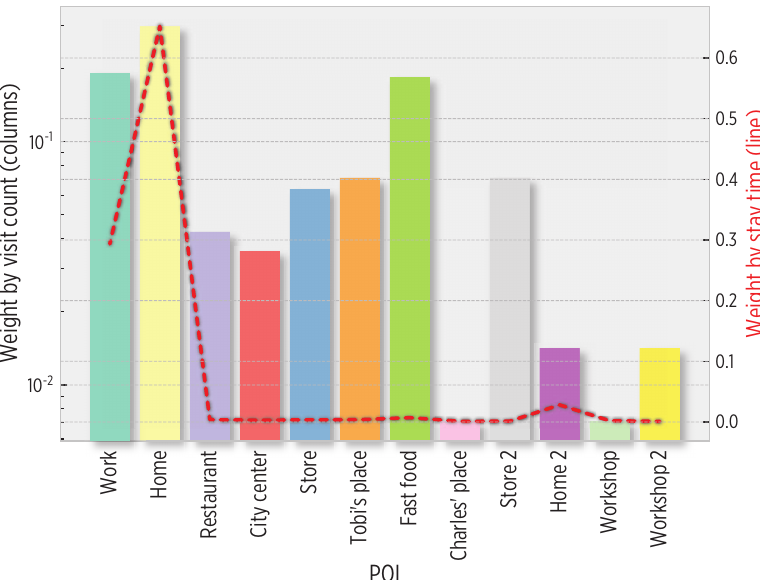
Figure 6. POI weights (%) based on visit count (Equation (7), logarithmic scale) and stay time (Equation (8)). Work and Home places have the largest stay time and visit count values, whereas Fast food is a frequently visited place with a small stay